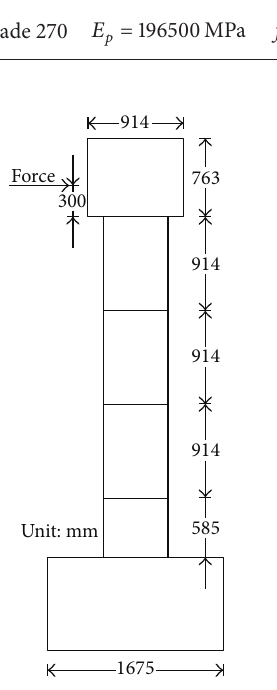
Figure 1: Geometry of the studied specimen